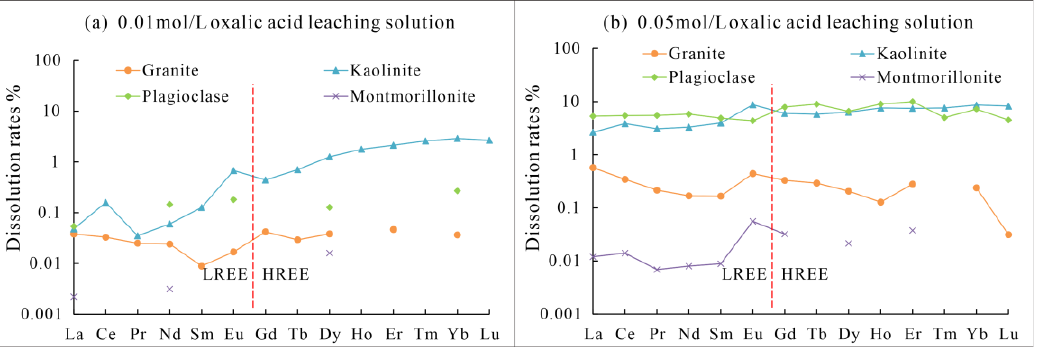
Figure 6. The dissolution rate of REE in oxalic acid leachates of different concentrations: ( a ) 0.01 mol/L oxalic acid leaching solution; ( b ) 0.05 mol/L oxalic acid leaching